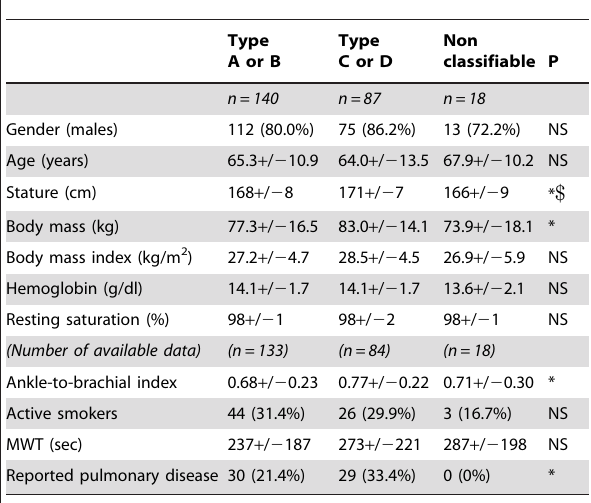
Table 1. Characteristics of patients showing assumed normal (A or B) or abnormal (C or D) tcpO 2 profile types or that could not be